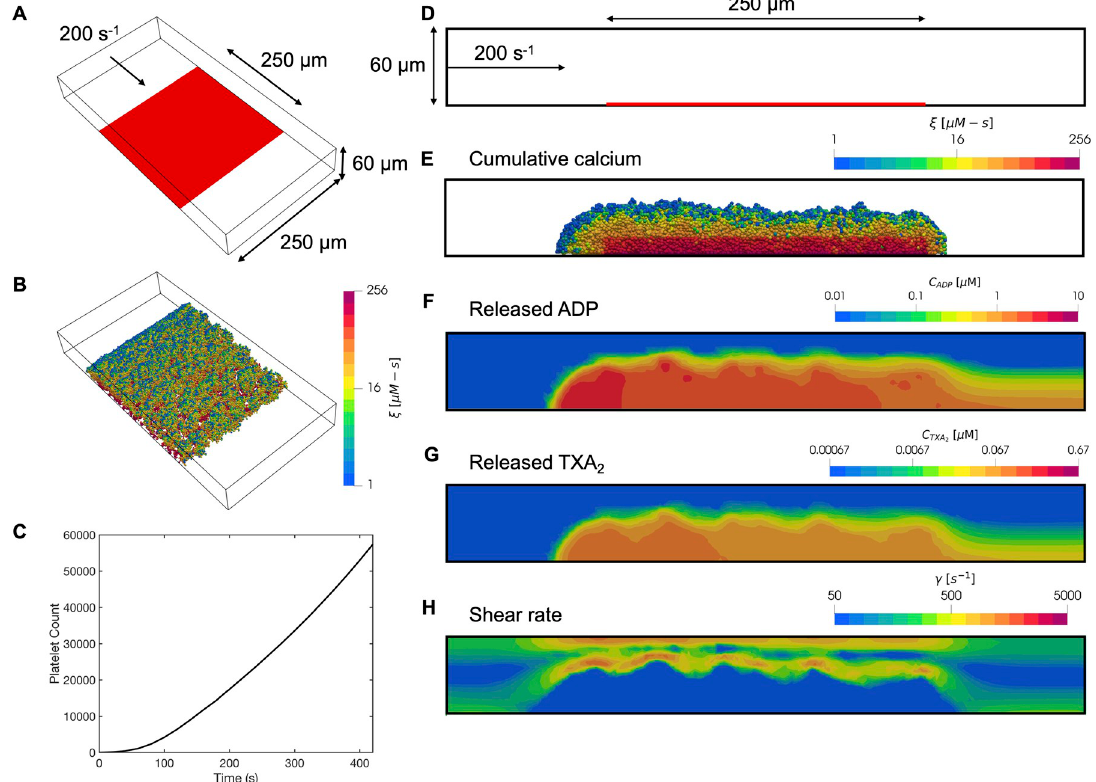
Fig 2. Simulation results of platelet aggregation under flow in the microfluidic device. Schematic of the microfluidic device geometry: (A) oblique view and (D) side view. Inlet flow: 200s -1 ; reactive surface containing collagen and TF: red bar. (B,E) Platelet activation (blue indicates inactivated and red, fully activated) and deposition after 400 seconds. (C) Dynamics of platelet aggregate count observed over time. Released (F) ADP and (G) TXA 2 , and (H) the local shear rate contours plotted along the center of the channel after 400